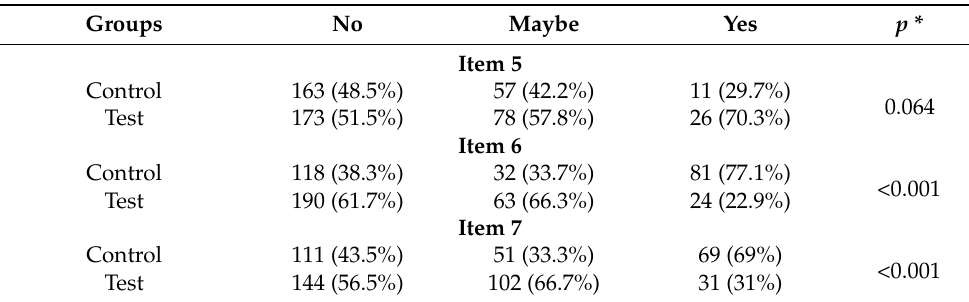
No.—number; %—percentage; * Fisher’s exact